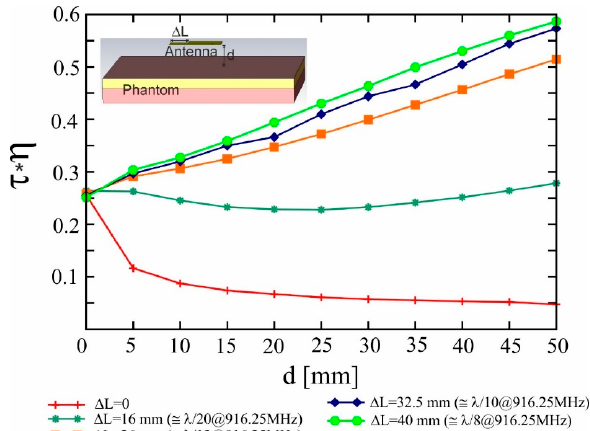
Figure 11. τ × η with respect to the distance from the body phantom for different extensions of the antenna ground plane.